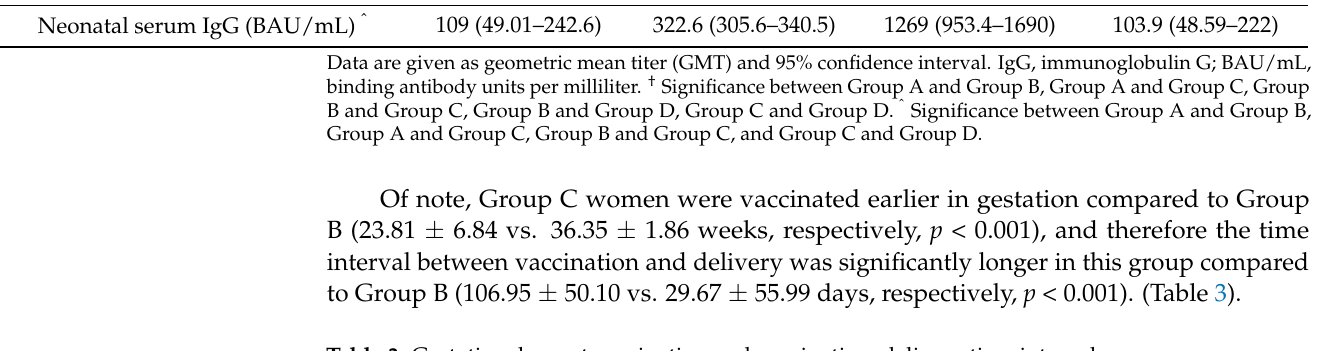
Table 3. Gestational age at vaccination and vaccination–delivery time